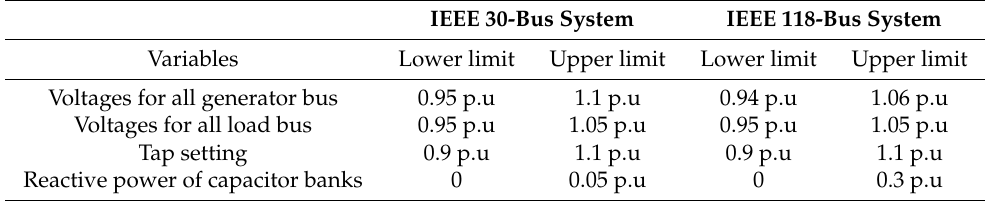
Table 1. Limit setting for control variables of the all-test systems